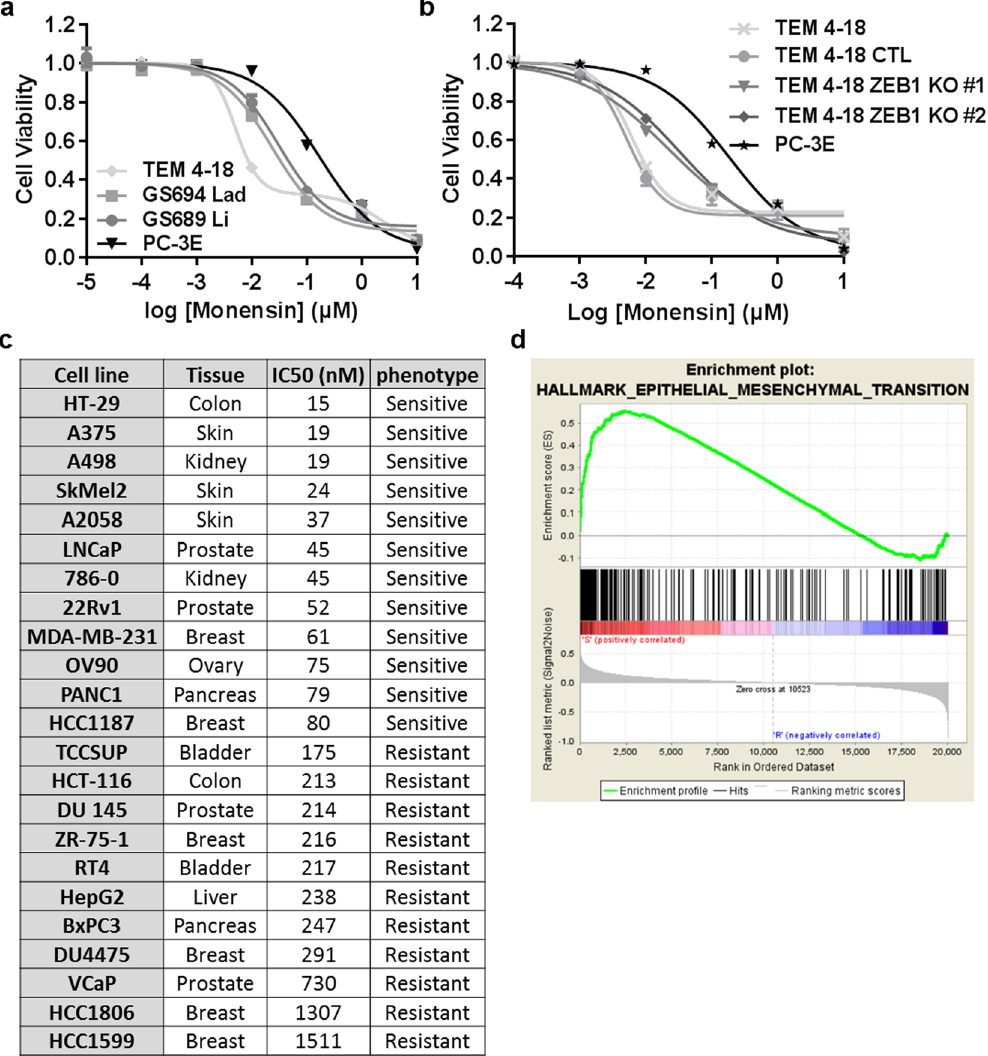
Figure 6. Monensin is selectively cytotoxic to a broad panel of cancer cell lines exhibiting EMT-like characteristics. ( a , b ) Cells were treated for 72 h with serial dilution of monensin (n ≥ 4). Relative cell viability was plotted against the logarithm of monensin concentration. ( c ) 23 human cancer cell lines were tested for their sensitivity to monensin (n ≥ 3). Cell lines were grouped as sensitive (IC 50 < 100 nM) or resistant (IC 50 > 100 nM). ( d ) The Cancer Cell Line Encyclopedia database was used to perform a Gene Set Enrichment Analysis. The hallmark for EMT was the top of the hallmark enriched in sensitive cell lines. The results represent the means ± SEM of at least 3 independent